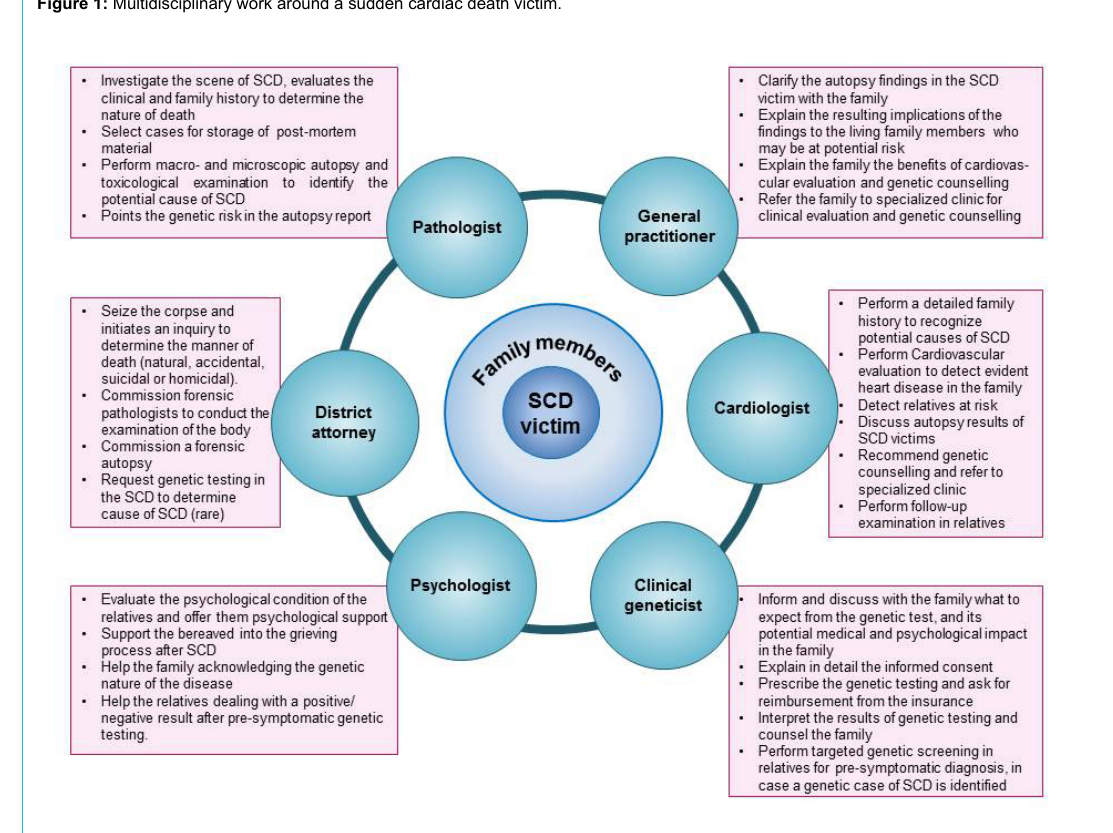
Figure 1: Multidisciplinary work around a sudden cardiac death